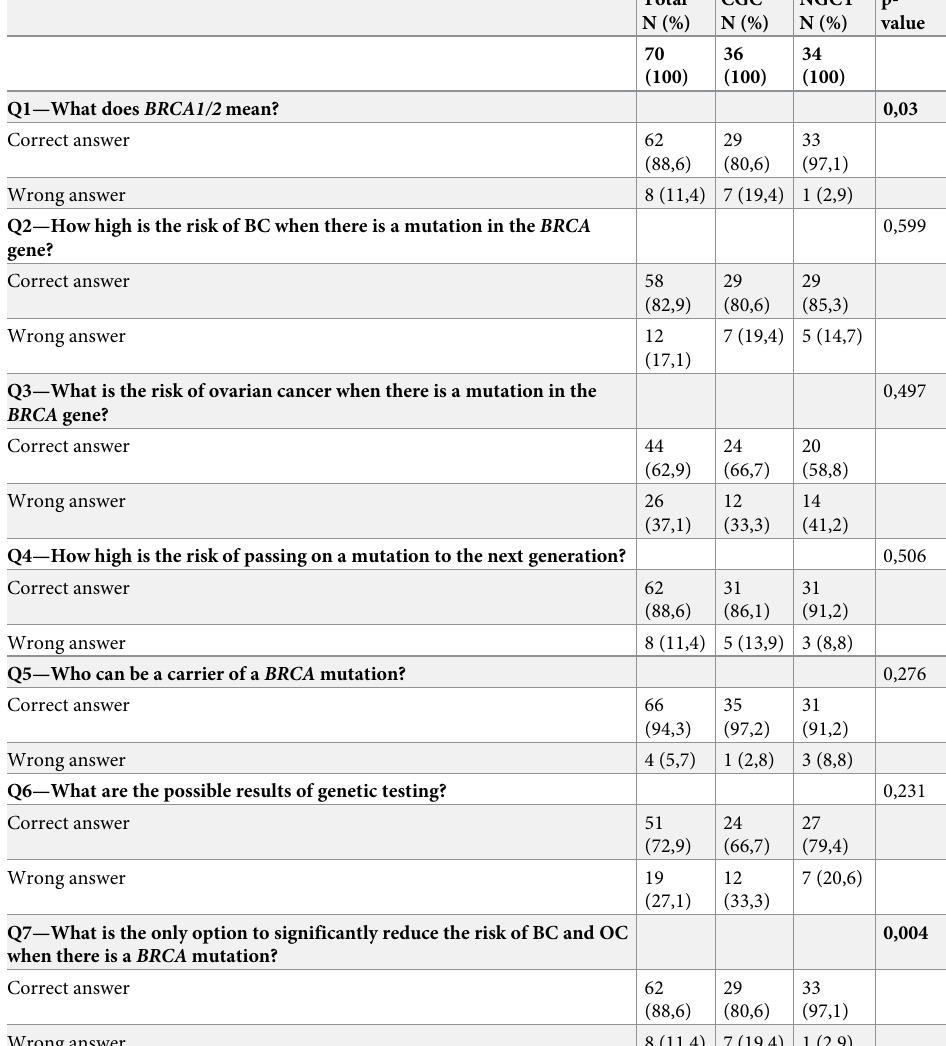
Table 2. How often was each question answered correctly or